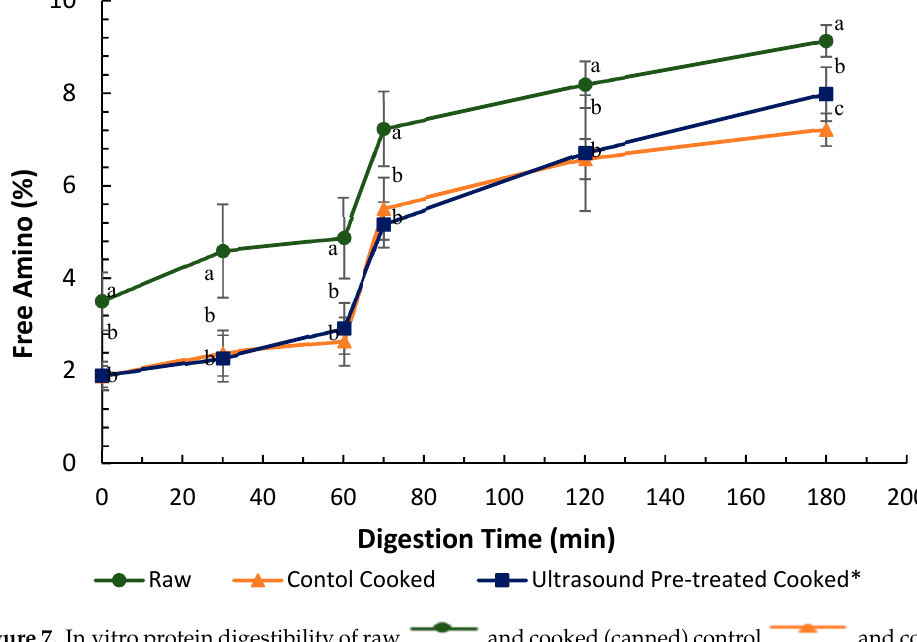
Figure 7. In vitro protein digestibility of raw and cooked (canned) control and cooked ultrasound pre-treated p ā ua determined based on ninhydrin-reactive free amino N released during gastro-small intestinal digestion (n = 3. Ultrasound treatment was done in water for 5 min followed by soaking in water for 24 h at 4 °C. Digestion times 0, 30 and 60 min represent 2, 30 and 60 min of digestion in the gastric phase following 2 min of oral digestion phase; 70, 120 and 180 represent 10, 60 and 120 min of digestion in the small-intestinal phase following 60 min of gastric and 2 min of oral digestion phases. Different letters in the same column represent a significant difference ( p < 0.05) .